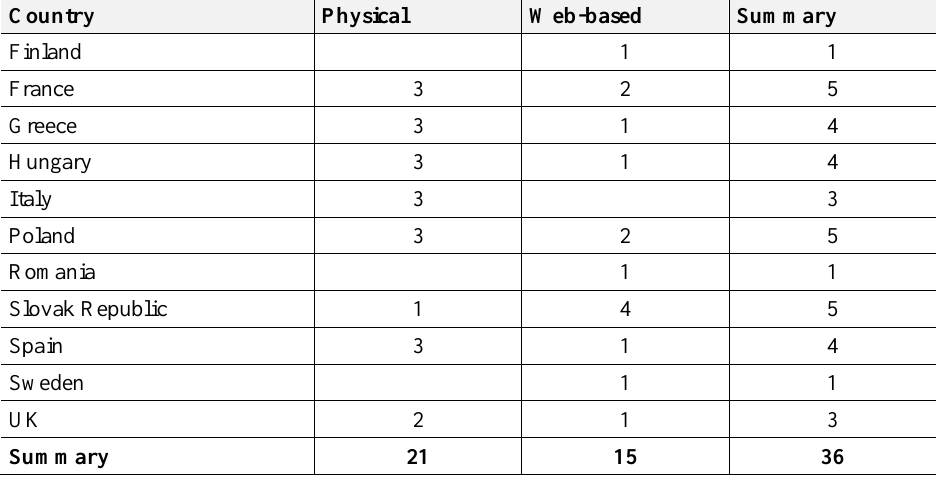
Table 1 – Sample distribution on Physical and Web-based digital public spaces Country Physical Web-based